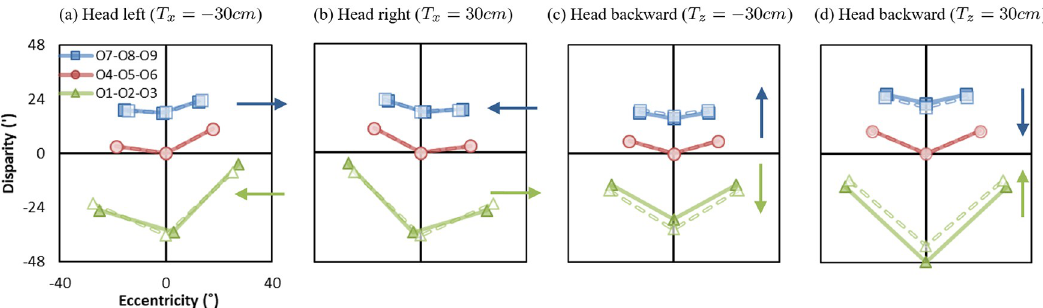
Fig 14. Effects of head translations in four conditions: The head translates (a) left ( T backward ( T z = − 30 cm ), and (d) forwards ( T z = 30 cm ). Solid lines represent the eccentricity-disparity in the original world ; D ) and dashed lines represent the eccentricity-disparity in the reconstructed world ( E ( E oc o eccentricity differences and vertical arrows show disparity